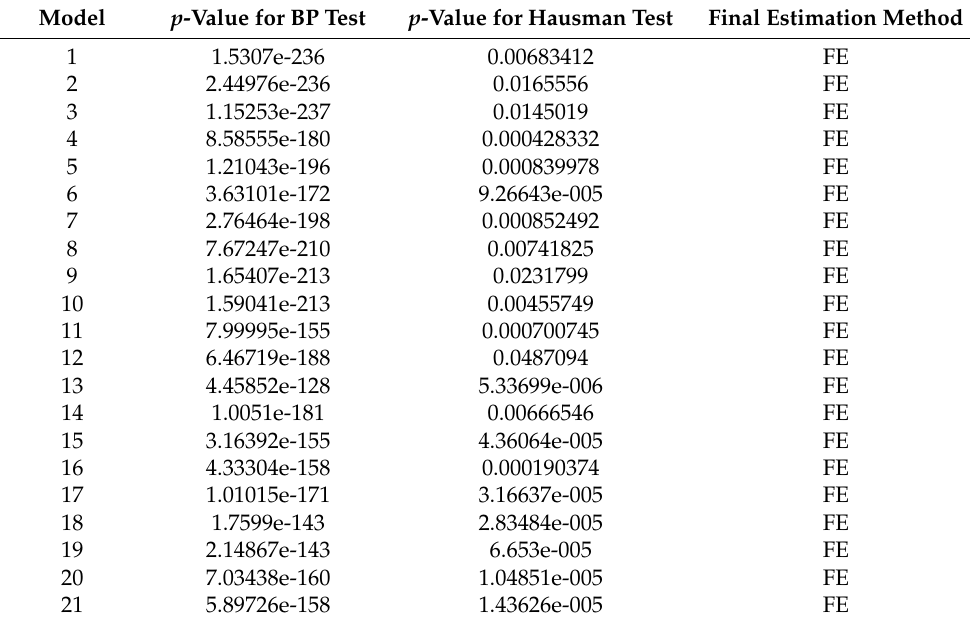
Table 2. Specification of the model estimation technique. Model p -Value for BP Test p -Value for Hausman